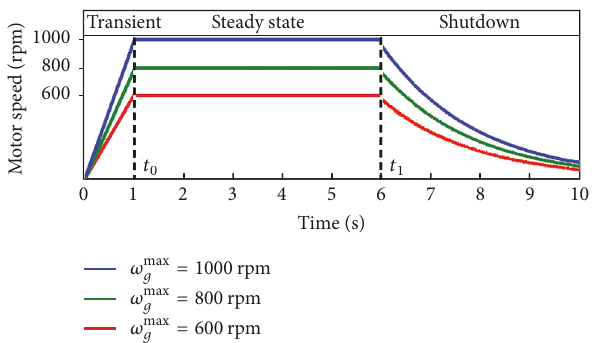
Figure 6: Motor speed for operational scenarios transient, steady state, and shutdown for 3 different maximum